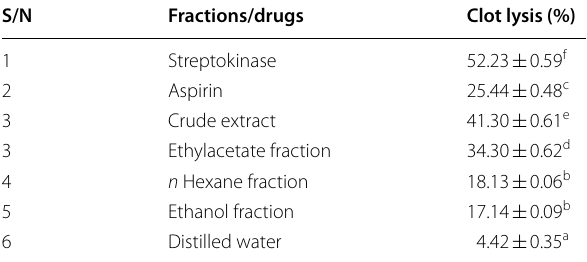
Results are presented as mean superscripts differ significantly ( P <